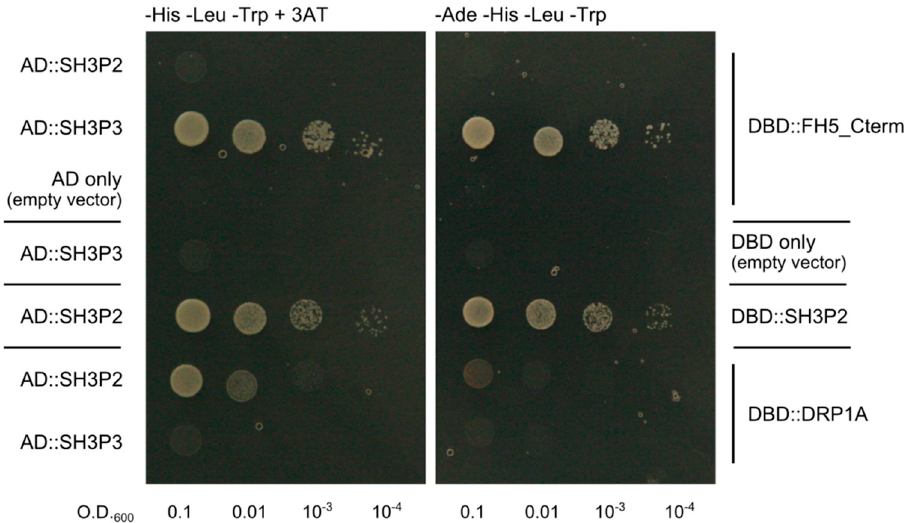
Figure 2. Results of a yeast two hybrid experiment showing that SH3P3, but not SH3P2, can bind the C-terminal cytoplasmic fragment of FH5 comprising the FH1 and FH2 domains (FH5_Cterm), while only SH3P2 but not SH3P3 can interact with the dynamin homolog DRP1A. Dimerization of SH3P2 is also demonstrated. Constructs marked as “DBD” are derived from the pGBKT7 vector and carry the DNA binding domain of the yeast GAL4 transcription factor; those labeled as “AD” are derived from the pGADT7 vector and carry the GAL4 activation domain. Yeast suspensions were plated on two types of substrate—a standard -His -Leu -Trp dropout medium containing 5 mM 3-aminotriazole (3AT; left ), and a -Ade -His -Leu -Trp dropout medium ( right ) providing more stringent selection. Calculated O.D. 600 of the plated yeast suspension is indicated.